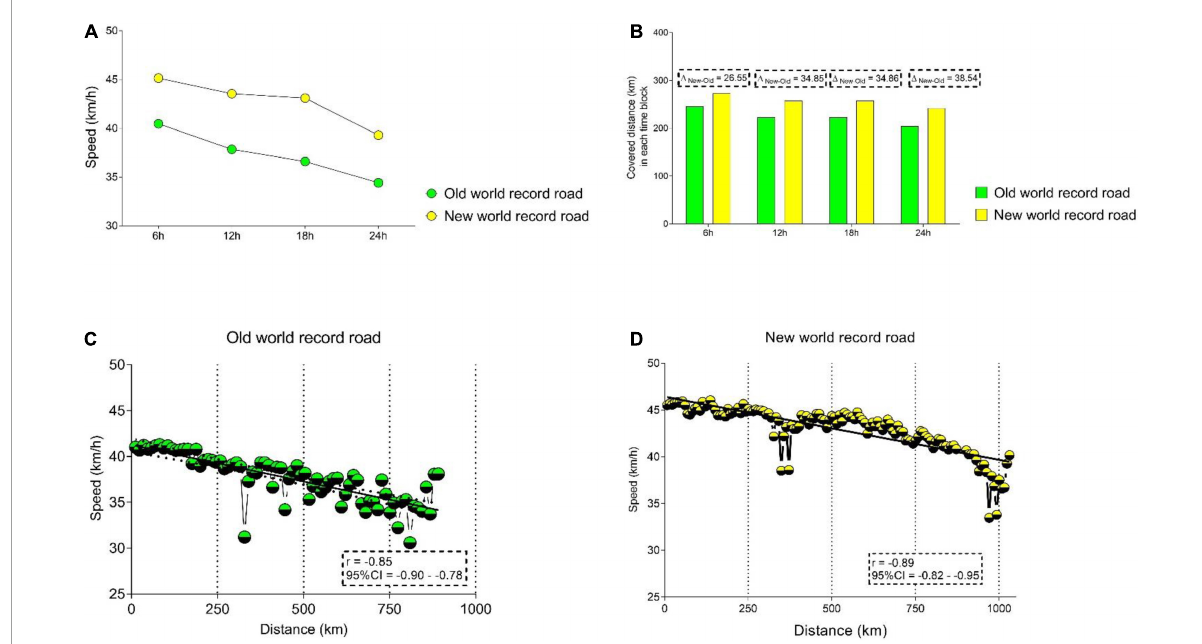
FIGURE2 Performance differences between the two records, by time intervals. (A) Speed (km/h) comparisons for both records in each time interval; (B) covered distance (km) comparison for both records in each time interval; (C) relationship between speed (km/h) and distance covered (km) in old word record; (D) relationship between speed (km/h) and distance covered (km) in new word